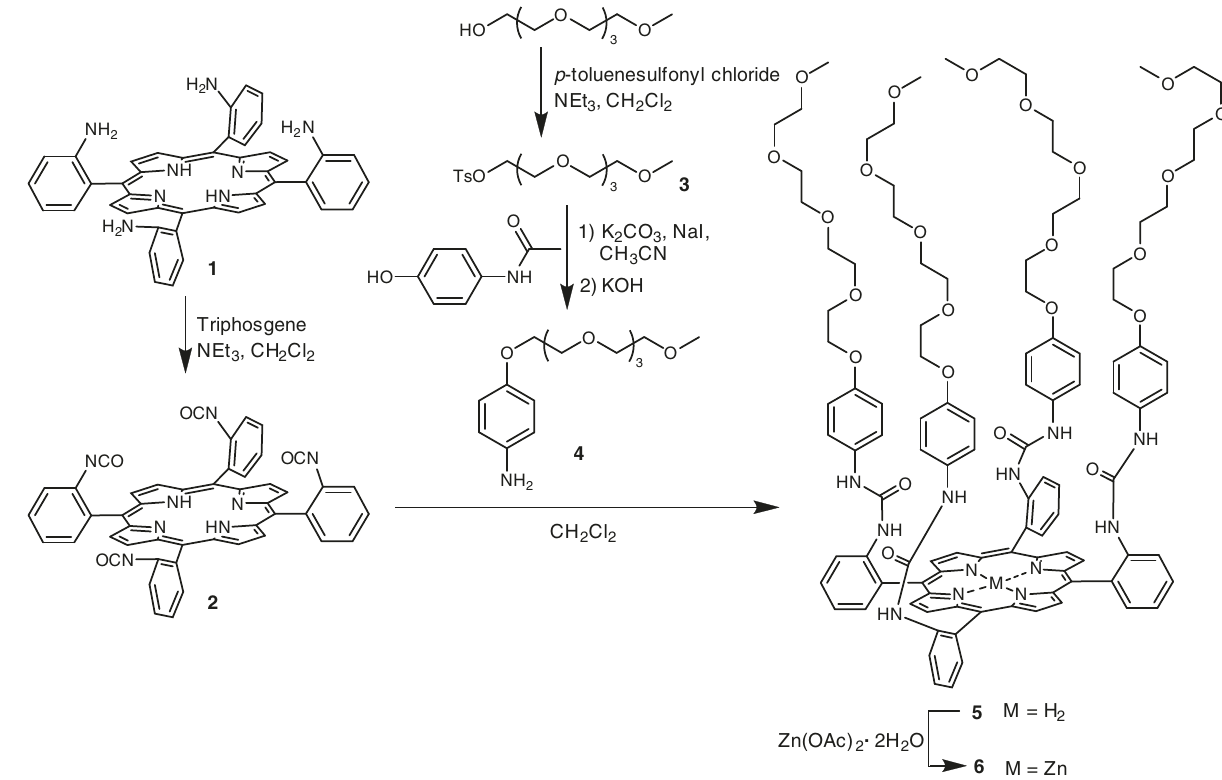
Fig. 1 Synthesis of amphiphilic porphyrin 5 and its Zn-complex